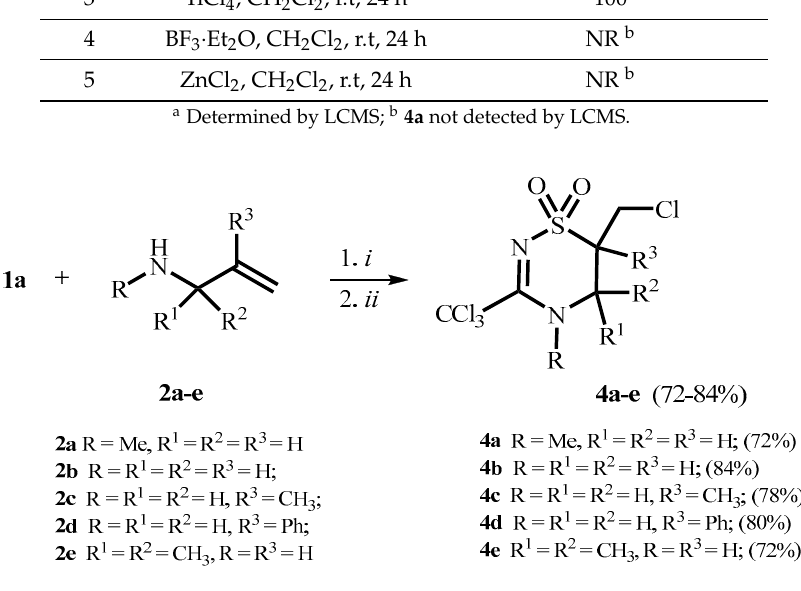
Table 1. Intramolecular heterocyclization of 3a .